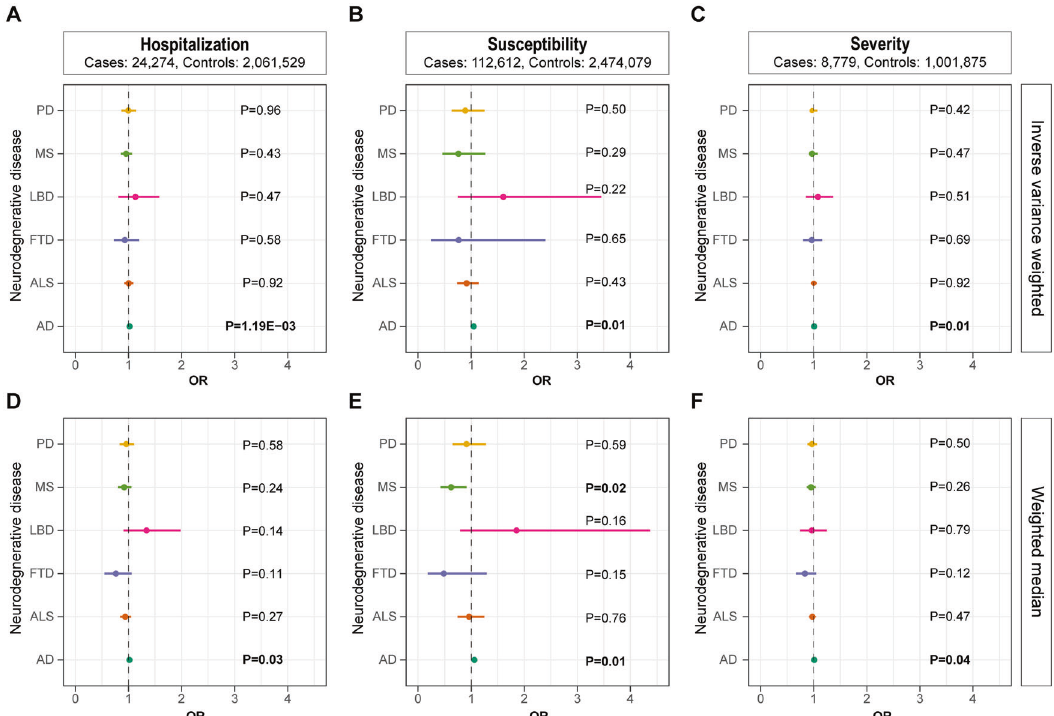
Fig. 2 Forest plot showing results from the Mendelian randomization analysis. Results from the Mendelian randomization (MR) analysis to evaluate causal role of A hospitalization, B susceptibility, and C severity of COVID-19 in neurodegenerative disorders using the inverse variance weighted method. Results from the MR analysis to evaluate potential causal role of D hospitalization, E susceptibility, and F severity of COVID- 19 in neurodegenerative disorders using the weighted median method. Estimates are per 1 standard deviation (SD) increase in the trait. Bold P value denotes nominal association ( P <